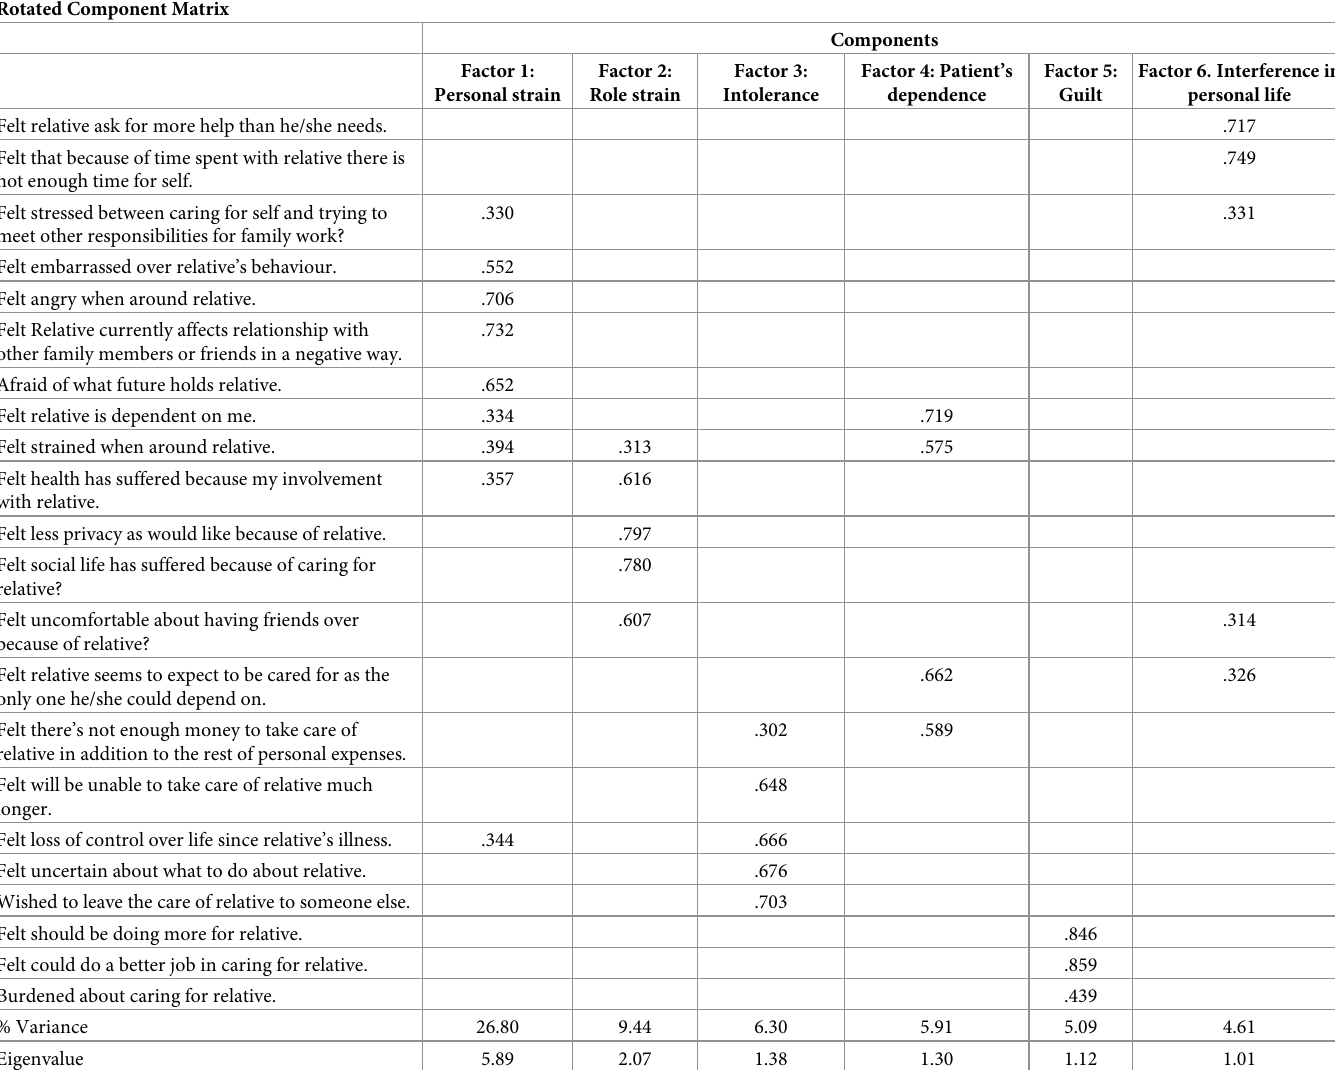
Table 7. The extracted components and factor loadings based on principal components analysis with Varimax rotation for the burden of care scale. Rotated Component